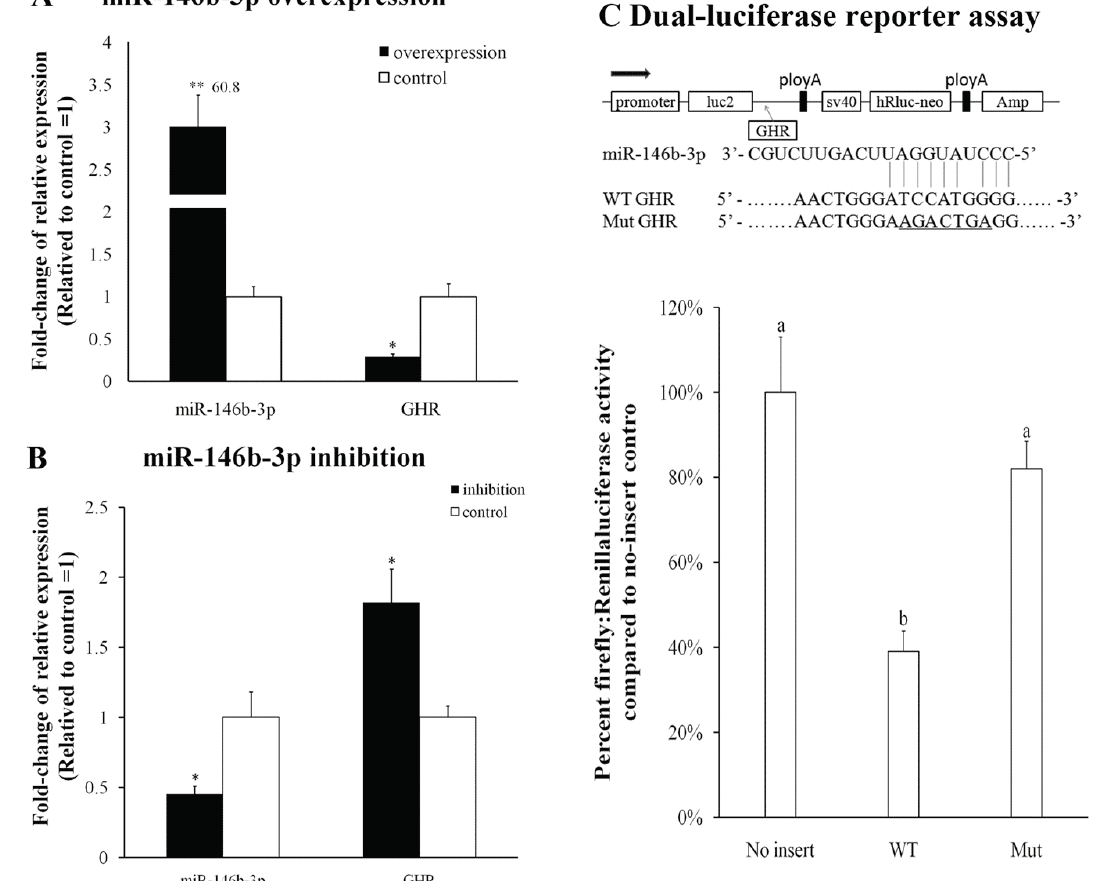
Figure 6. GHR is a target of miR-146b-3p in chickens. ( A ) The mRNA expression of c-GHR is significantly reduced after miR-146b-3p transfection in DF-1; ( B ) The mRNA expression of c-GHR is significantly increased after miR-146b-3p inhibitor transfection in DF-1; ( C ) DF-1 cells were transfected with miR-146b-3p mimic and co-transfected with no-insert control; c-GHR wild-type or mutant luciferase reporters. The predicted binding site and mutated site of miR-146b-3p in c-GHR is shown. All of the results are expressed as the mean ± S.E.M. of three replicates. * p < 0.05; ** p < 0.01; a,b p < 0.05. WT indicates c-GHR wild-type luciferase reporter and Mut indicates c-GHR mutant luciferase